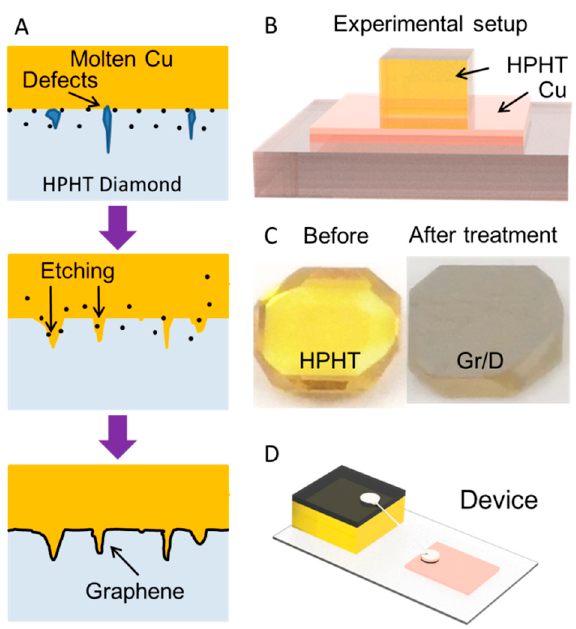
Figure 1. ( A ) Schematic diagram of graphene formation. ( B ) Scheme of preparation of graphene/diamond (G/D) electrode using chemical vapor deposition (CVD) method. ( C ) Photograph of sample before and after thermal treatment. (D) Scheme of the device after encapsulation